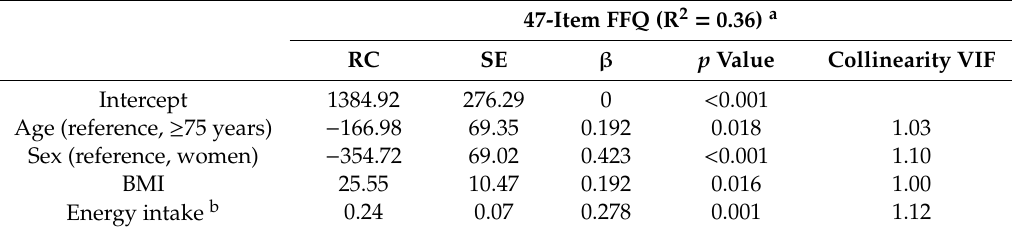
Table 4. Stepwise multiple regression analysis with the total energy expenditure measured by doubly labeled water as a dependent